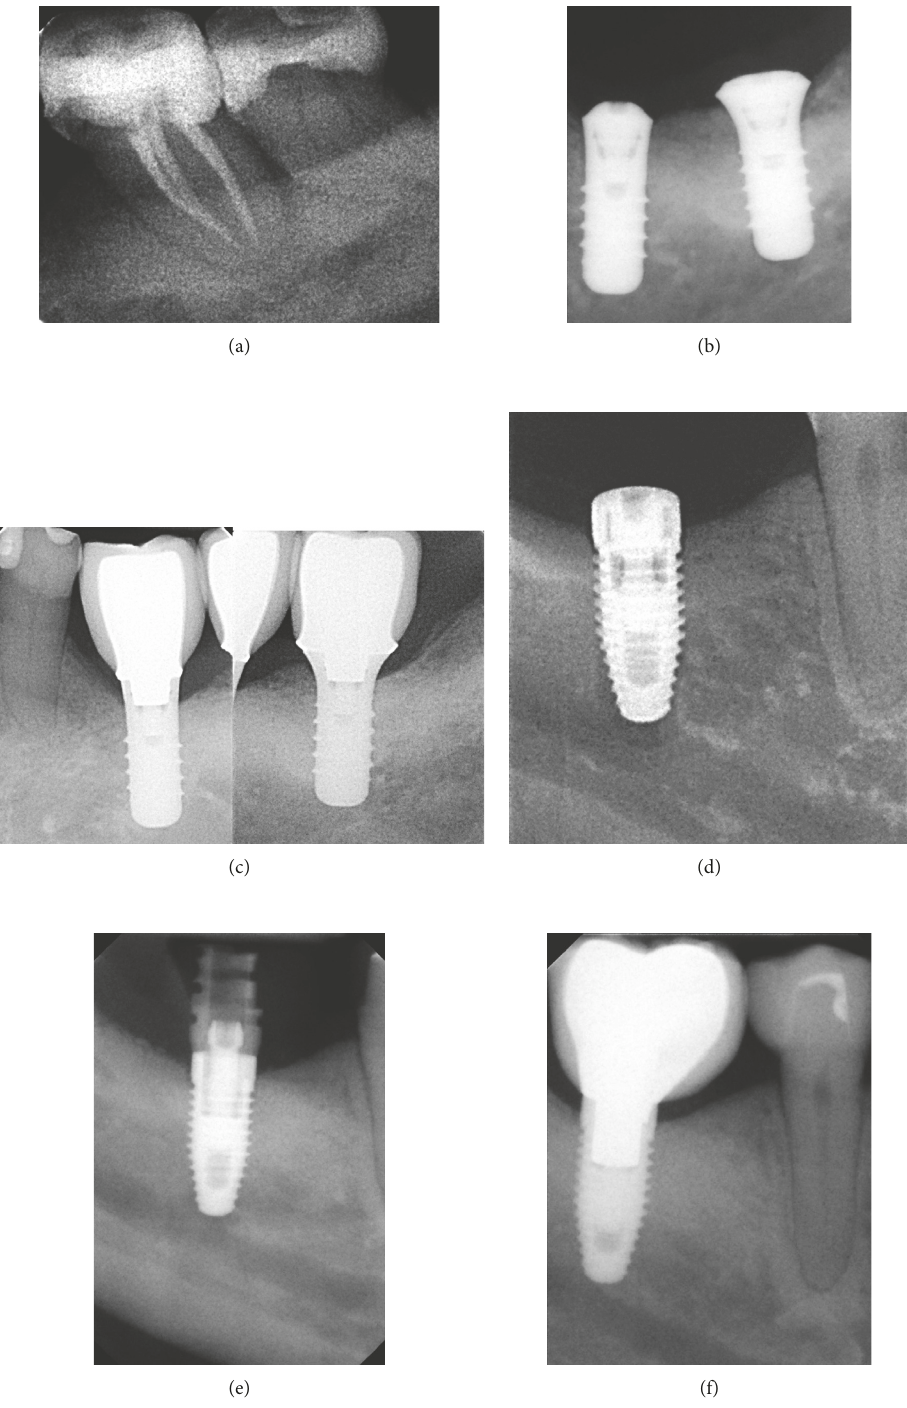
Figure 1: Successful cases. Patient 1: initially, an important reduction of support tissues was observed (a), and periapical X-ray obtained during the surgical procedure (b) and 5 years of follow-up (c). Patient 2: periapical X-ray obtained during implant surgery (d), restorative processing (e), and 5 years of follow-up